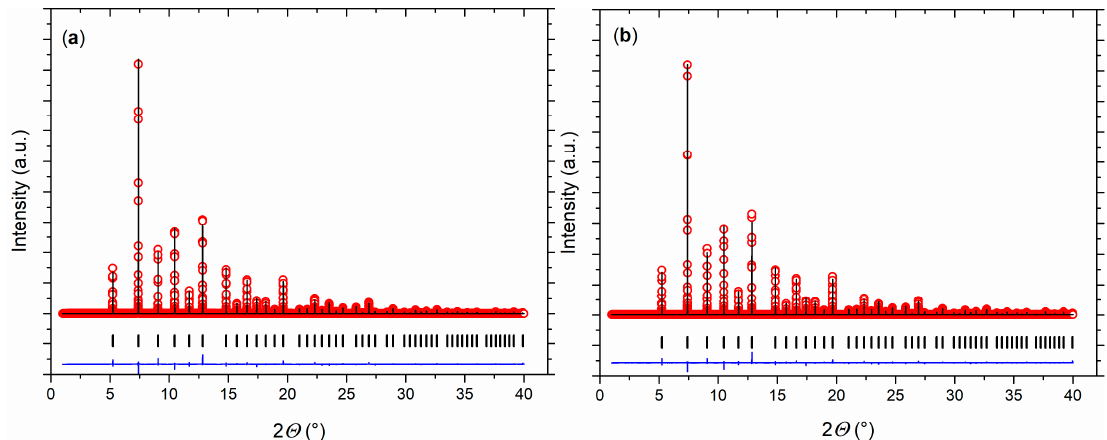
Figure 3. Rietveld refinements of the crystal structure of Eu 0.8 Ca 0.2 TiO 3– δ at ( a ) 300 K and ( b ) 100 K. Measured data (red open circles), calculated data (black line), and differential curve (blue line) are shown. The vertical ticks mark the position of the Bragg reflections. Table 1. Results of Rietveld refinements of the crystal structure of Eu 0.8 Ca 0.2 TiO 3– δ at 300 K and 100 K.